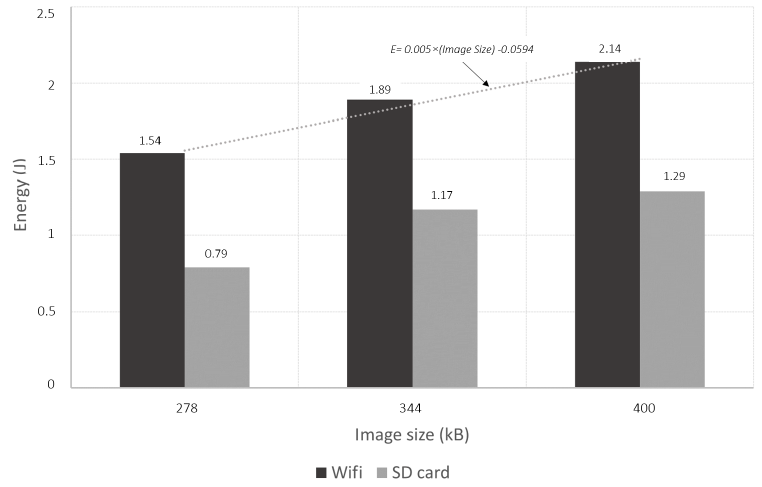
Figure 8. Energy consumed for Wi-Fi transmission and SD card recording on different image